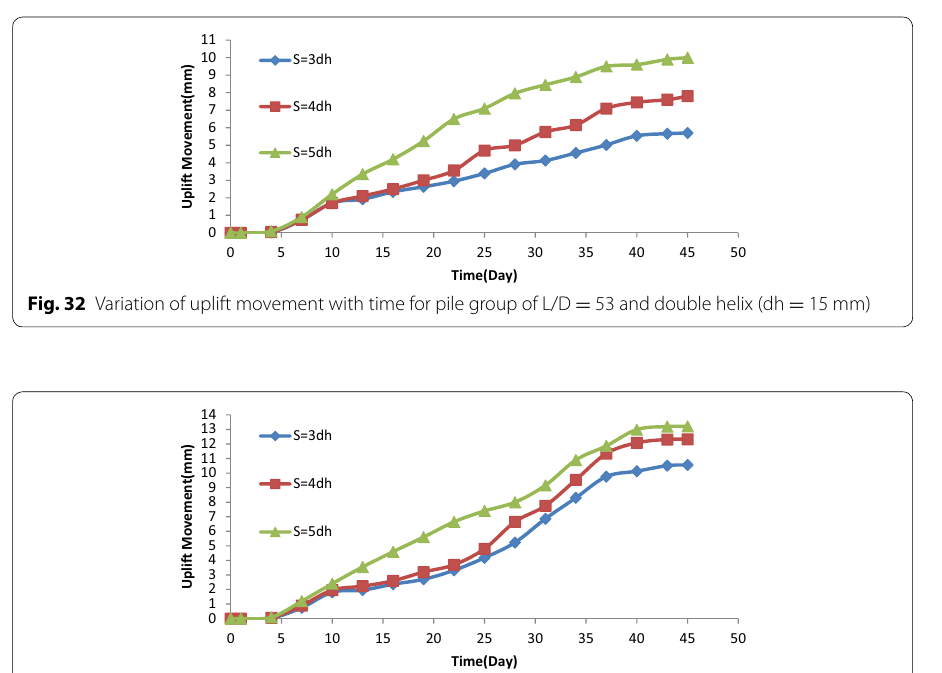
53 and double helix (dh =